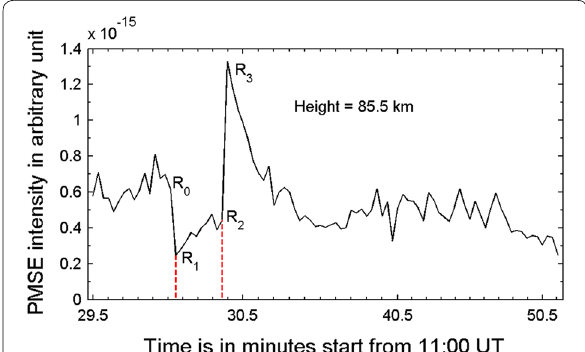
Fig. 1 An example of PMSE overshoot characteristic curve (OCC) for VHF radar on July 13, 2007, showing the backscatter sampling intervals R 0 , R 1 , R 2 and R 3 . The heater was switched-on at 11 h 30 min UT and switched-off at 11 h 30 min 20 s UT. The heater-on time is shown between the vertical dashed